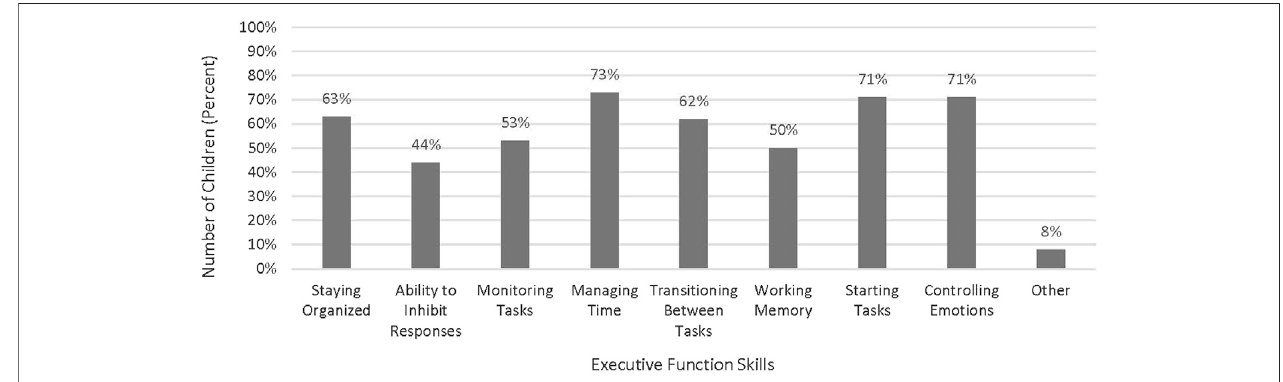
FIGURE 1 | Number of children experiencing dif fi culty staying organized, inhibiting responses, monitoring tasks, managing time, transitioning between tasks, holding mental information (working memory), starting tasks, and/or controlling emotions during COVID-19 pandemic (caregiver report, n (cid:1) 580, 70% male, average age (cid:1) 10.14 years, SD (cid:1)